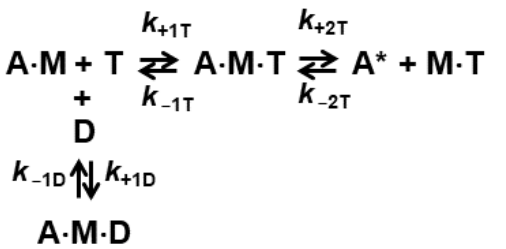
Figure 4 . Inhibition of the ATP-induced actomyosin dissociation with ADP. A = pyrene-labeled ac- tin, M = myosin, T = ATP. A* = actin with the high pyrene